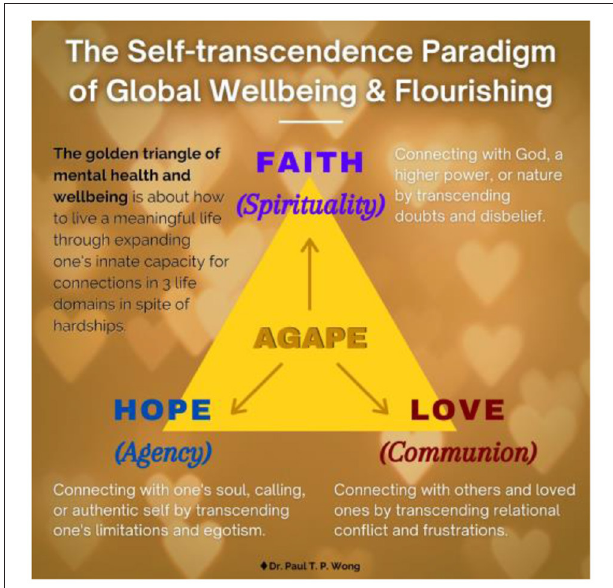
FIGURE 5 | The golden triangle of self-transcendence.